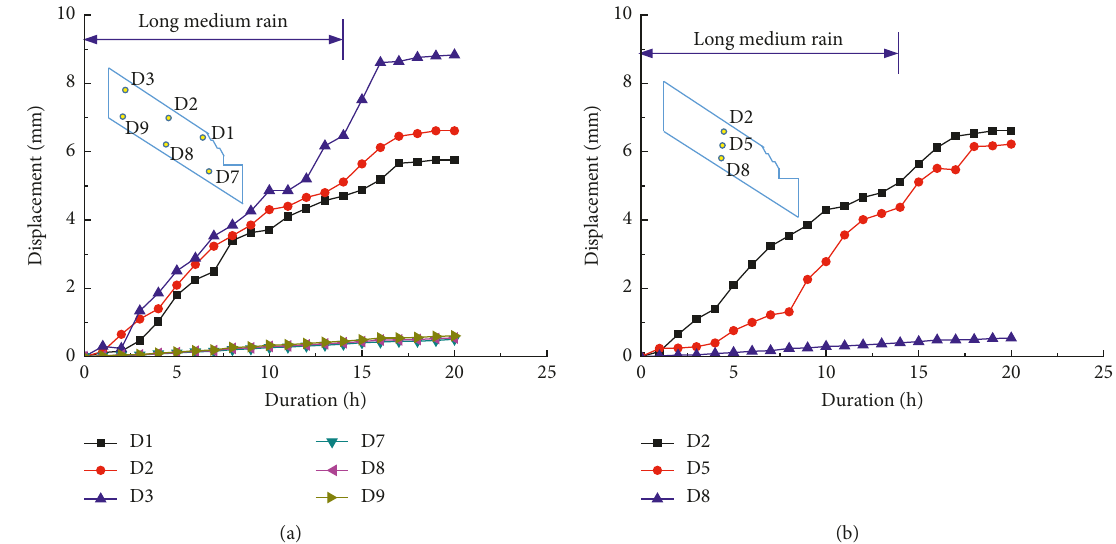
Figure 6: Displacement history in M2 slope along the (a) transverse direction and (b) depth direction.